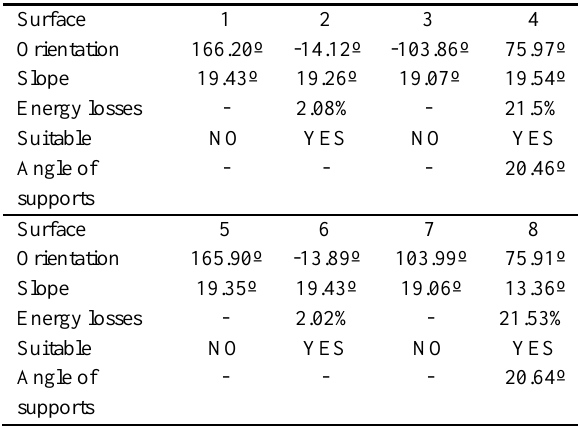
Figure 13. RGB Orthoimage of the study area.